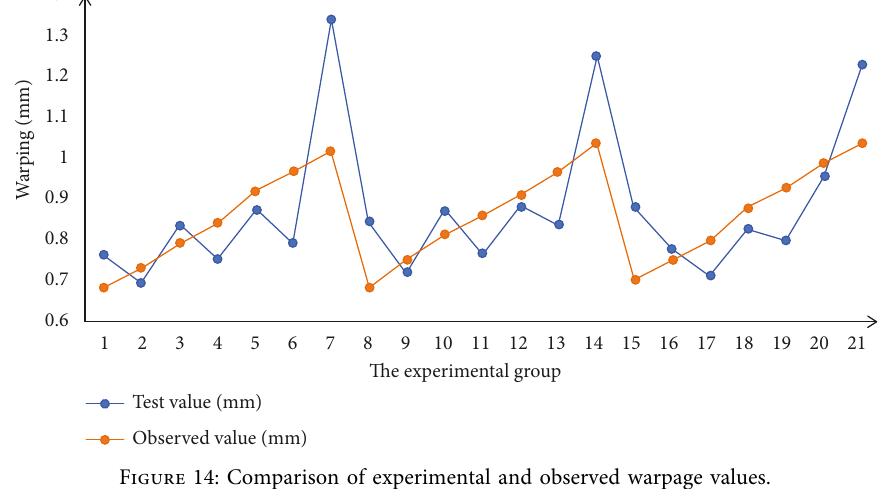
Figure 14: Comparison of experimental and observed warpage values.